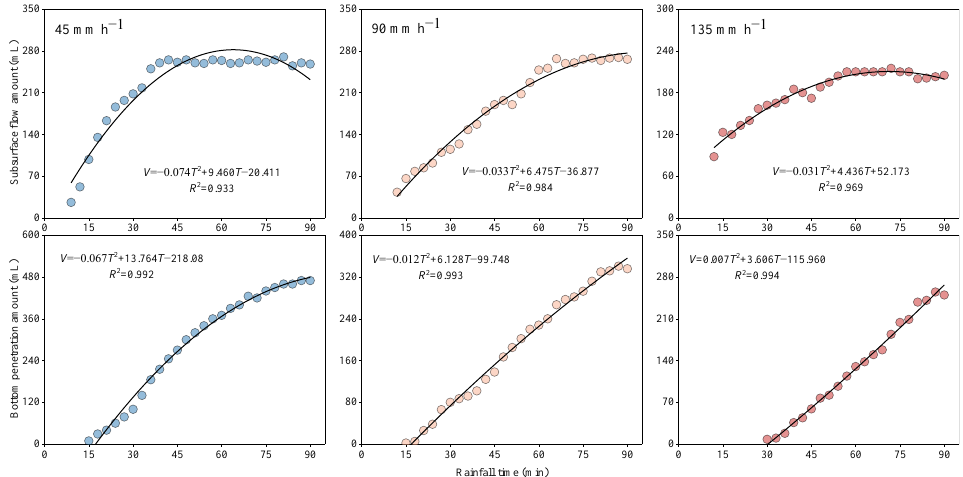
Figure 10. Relationships between the times and subsurface flow and bottom penetration during the rainfall simulations.